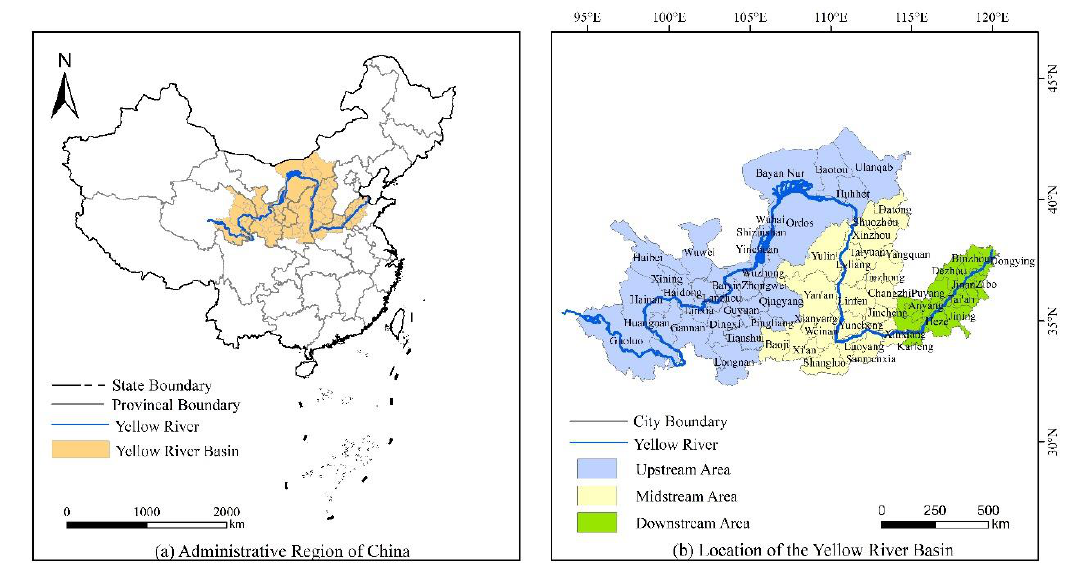
Figure 2. Location map of the Yellow River Basin, China.